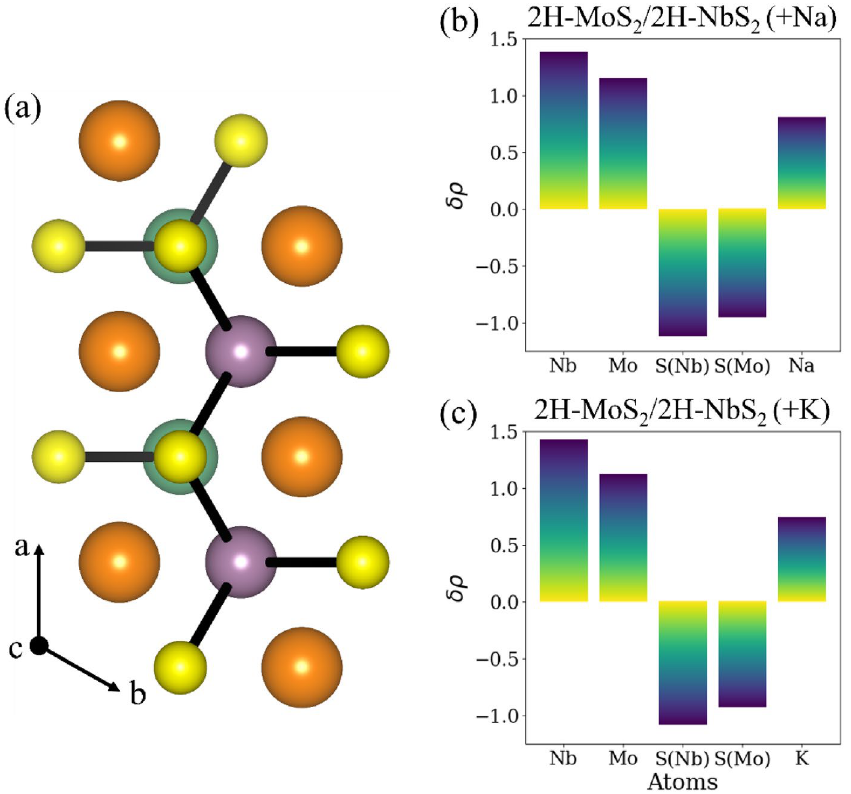
Figure 3. ( a ) Top view of 2H-MoS 2 /2H-NbS 2 heterostructures (alternating layers of NbS 2 and MoS 2 ) with ions at the lowest energy binding site (O h /H site). Charges transferred from different atoms in ( b ) Na-ion intercalated and ( c ) K-ion intercalated heterostructures are computed using Bader analysis. A positive value implies that the atom lost electrons, while a negative value indicates that the atom has gained